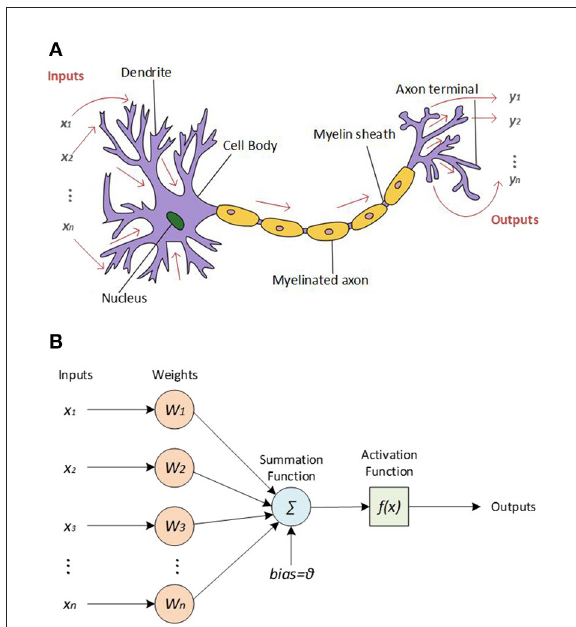
FIGURE2 (A) Diagram of two neurons’ connection structure and synapses (B) Schematic diagram of the processing of input signals by neurons in a neural network.